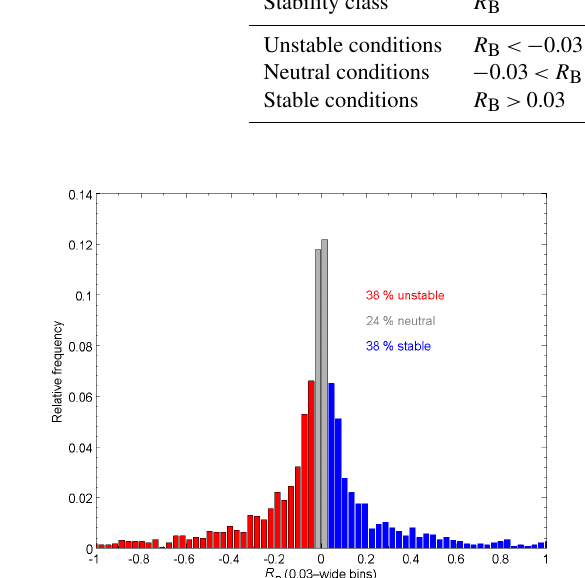
Figure 10. L distribution using thresholds in Table 2. Note that some neutral cases are outside of these axes. Includes data filtered for tower 80m wind speeds between 3.5 and 25.0ms − 1 , 87m wind directions between 235 and 315 ◦ , and for normal turbine